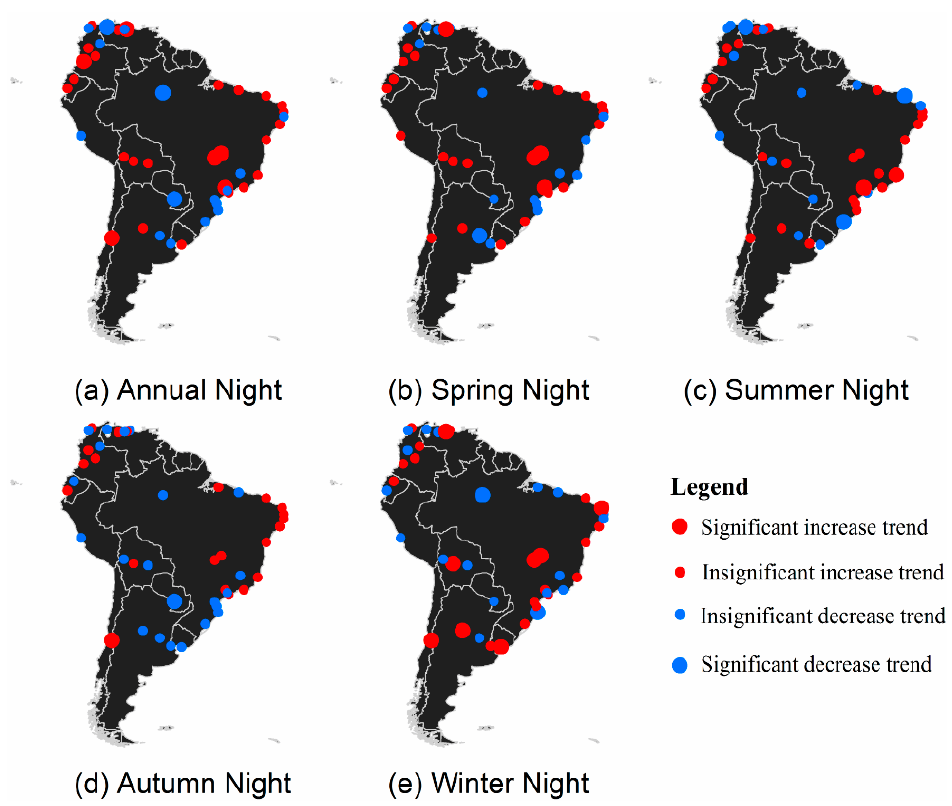
Figure 6. Temporal trends in the night-time SUHIIs for each city from 2003 to 2016.